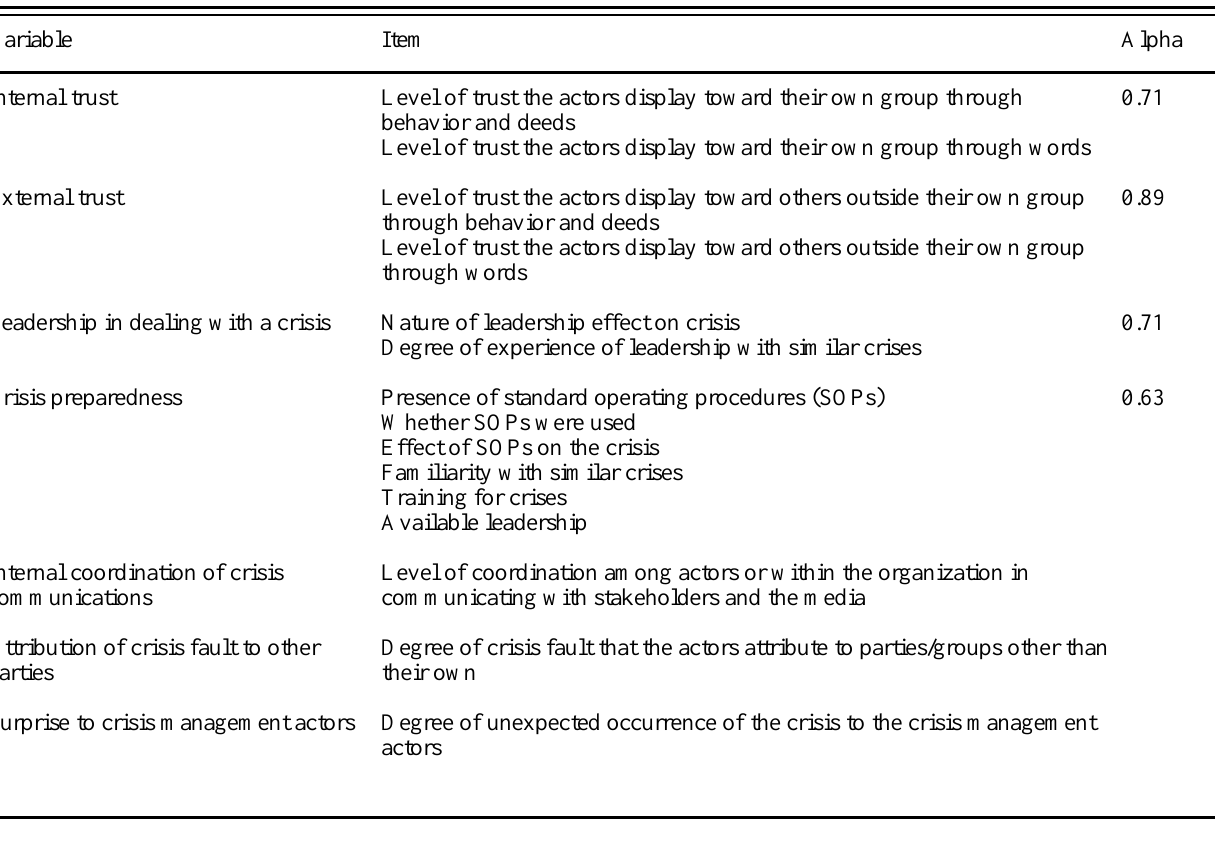
Table 2. Measurement items and their